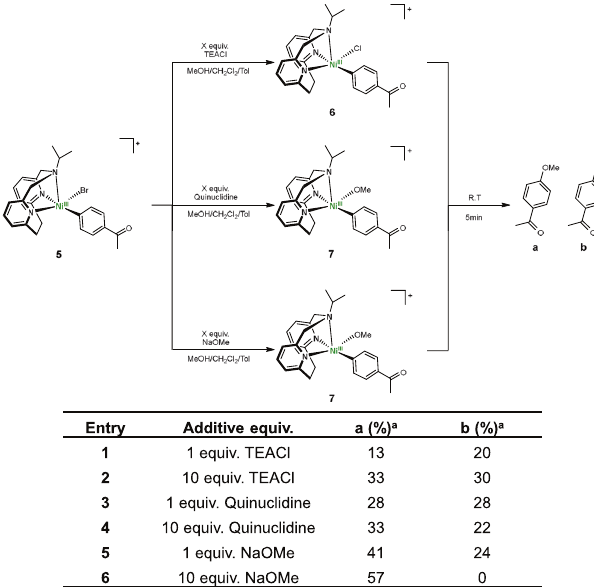
Fig. 6 Stoichiometric reactivity studies. Stoichiometric reactivity of 5 with TEACl, quinuclidine, or NaOMe to yield the C ‒ O coupled product through reductive elimination from Ni III intermediates.